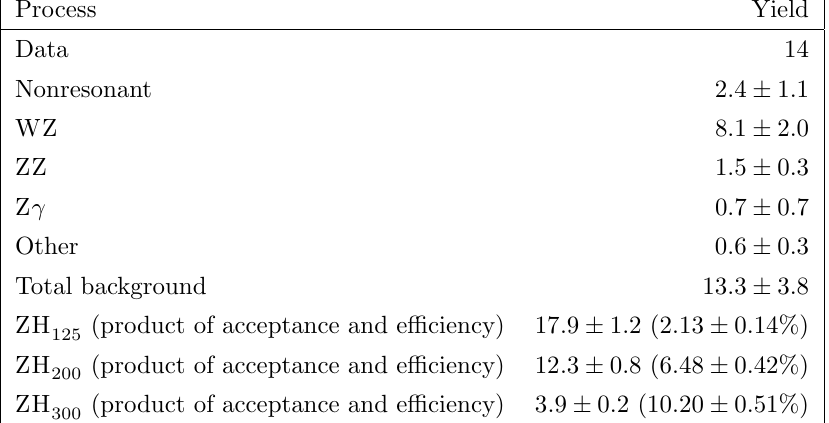
for all three m values shown. The ZH H